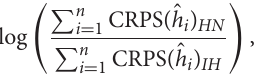
to the conditional haplotype variance: